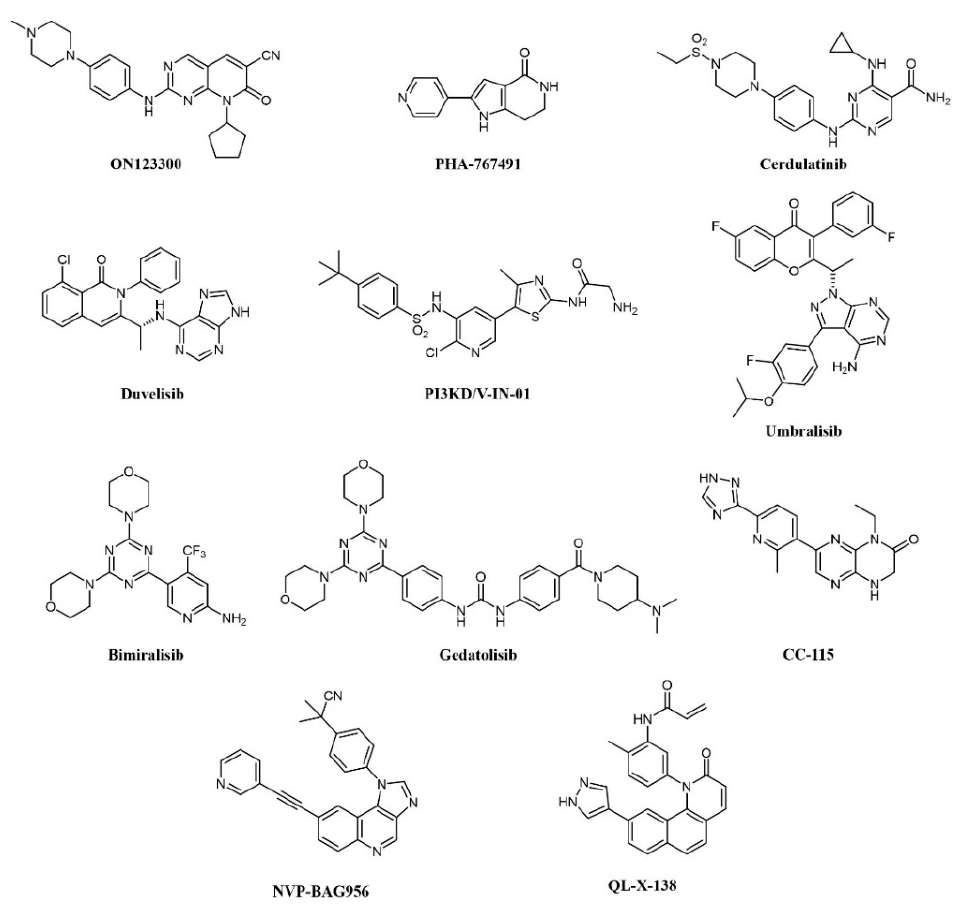
Figure 7. Chemical structure of dual kinase inhibitors used for lymphoid tumors.